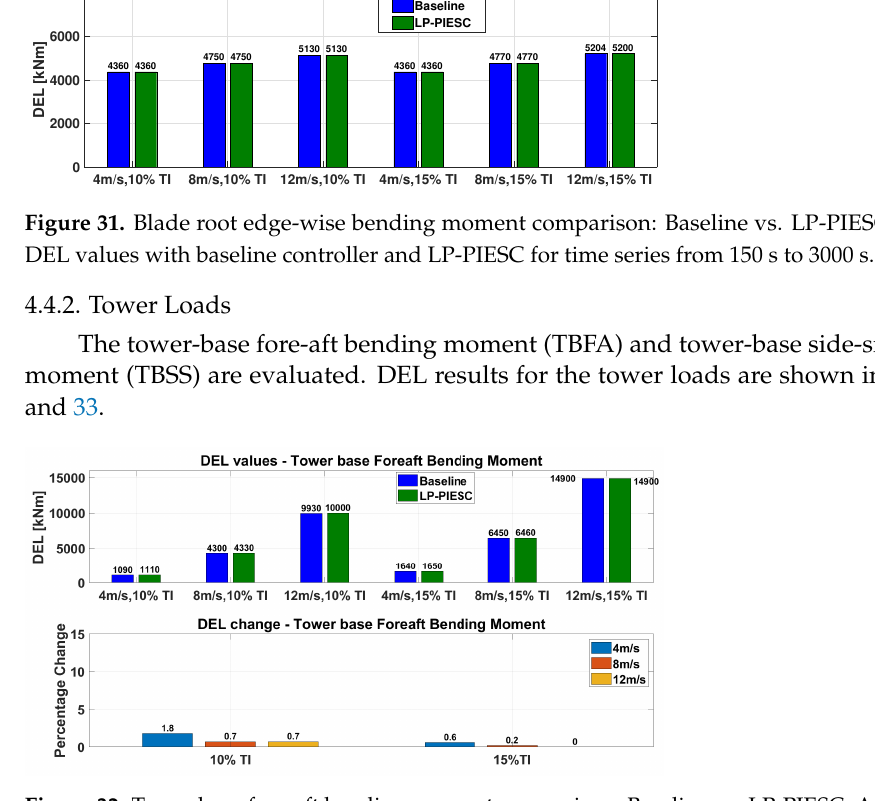
Figure 32. Tower base fore-aft bending moment comparison: Baseline vs. LP-PIESC. Aggregate DEL values with baseline controller and LP-PIESC ( top ), percentage change in DEL ( bottom ) for time series from 150 s to 3000 s.